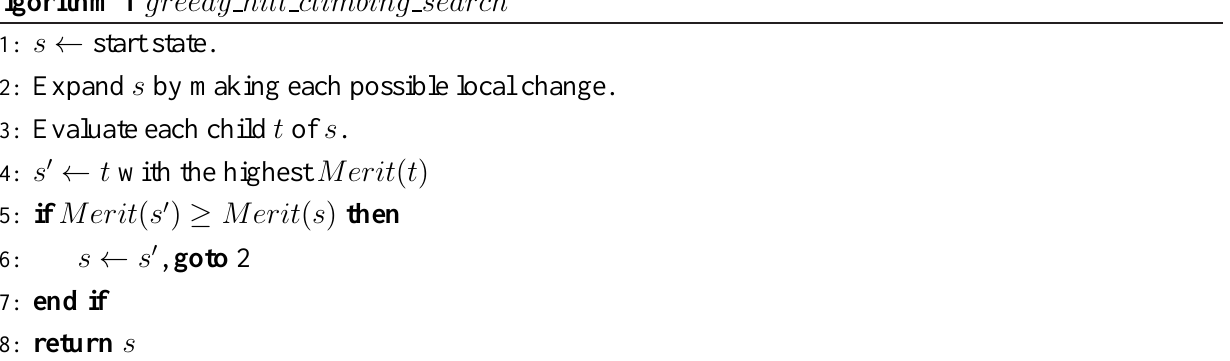
Algorithm 1 greedy hill climbing search